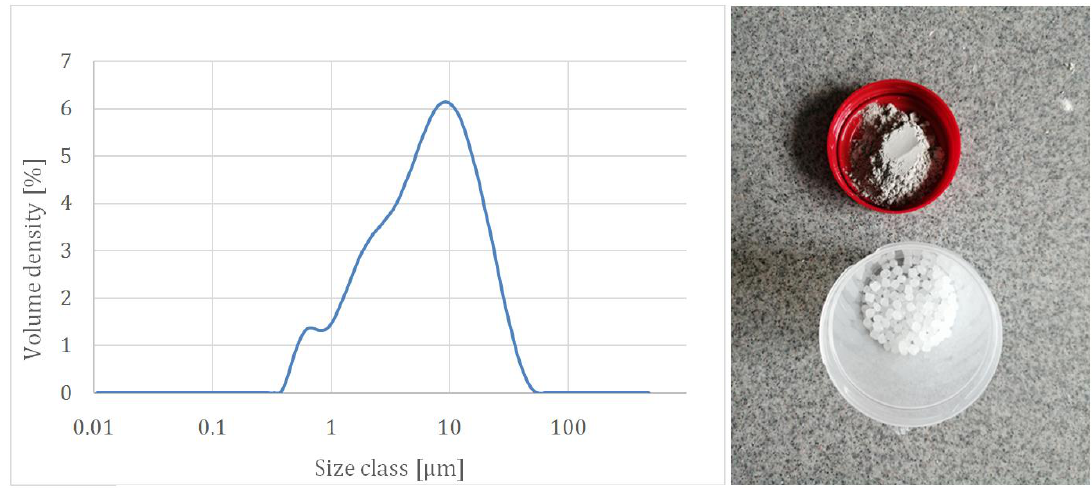
Figure 2. The particle size distribution of the obtained glass powder (left) and the powder with low-density polyethylene (LDPE) granules (right).